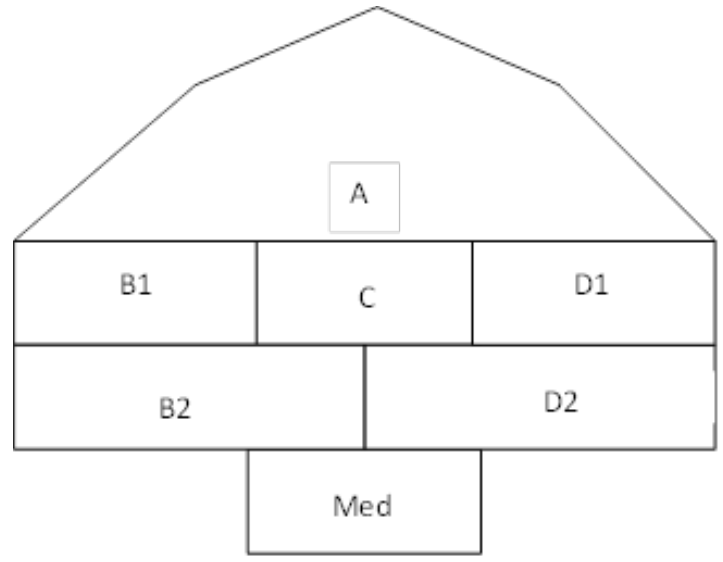
Figure 1 . Schematic of facility in which belugas were housed. Not drawn to